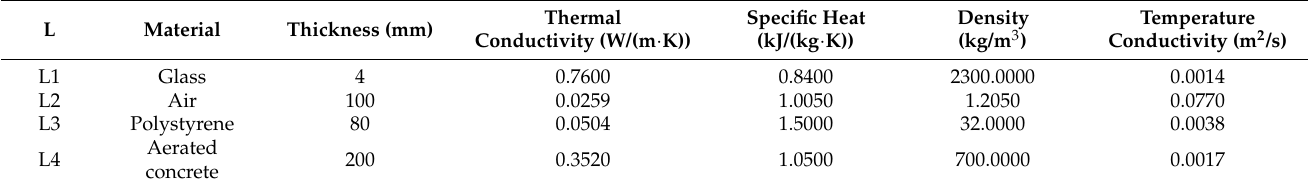
Table 6. Thermophysical parameters of the heat collection wall model.